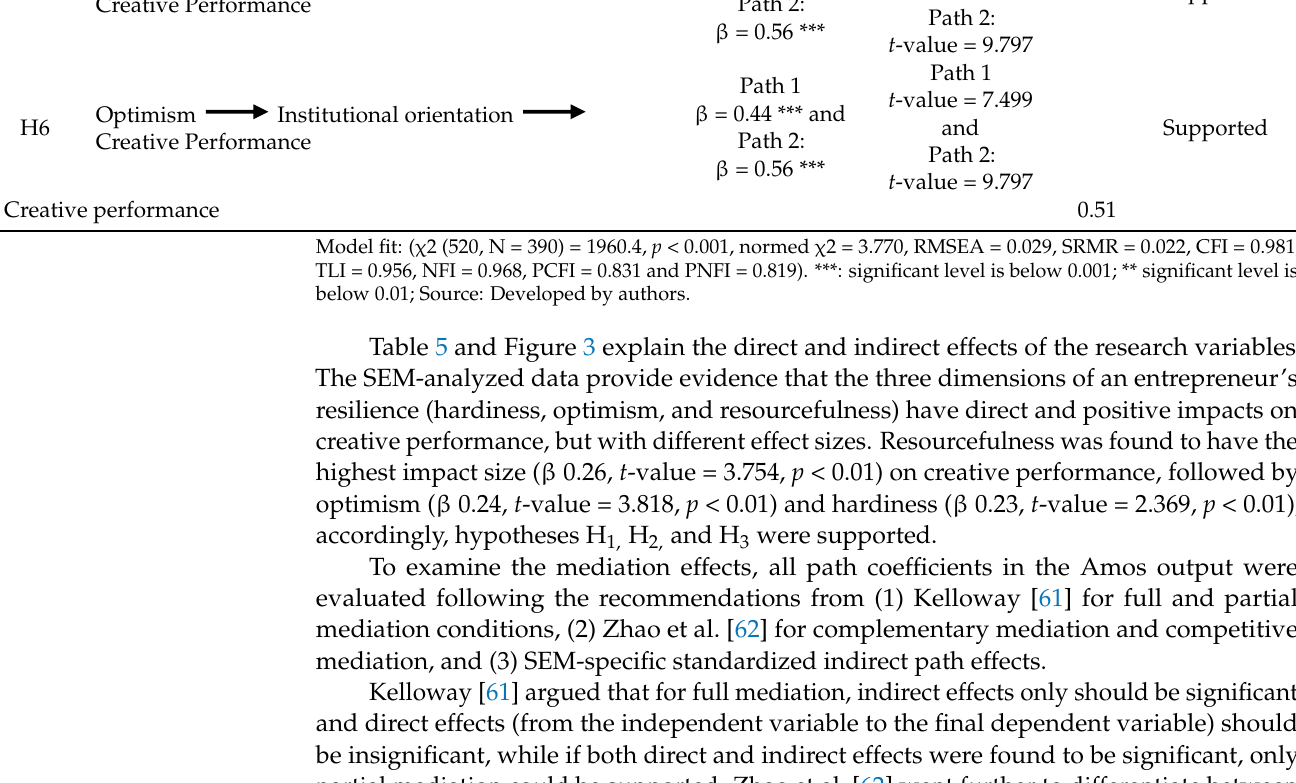
Table 5. The results of the structural model.